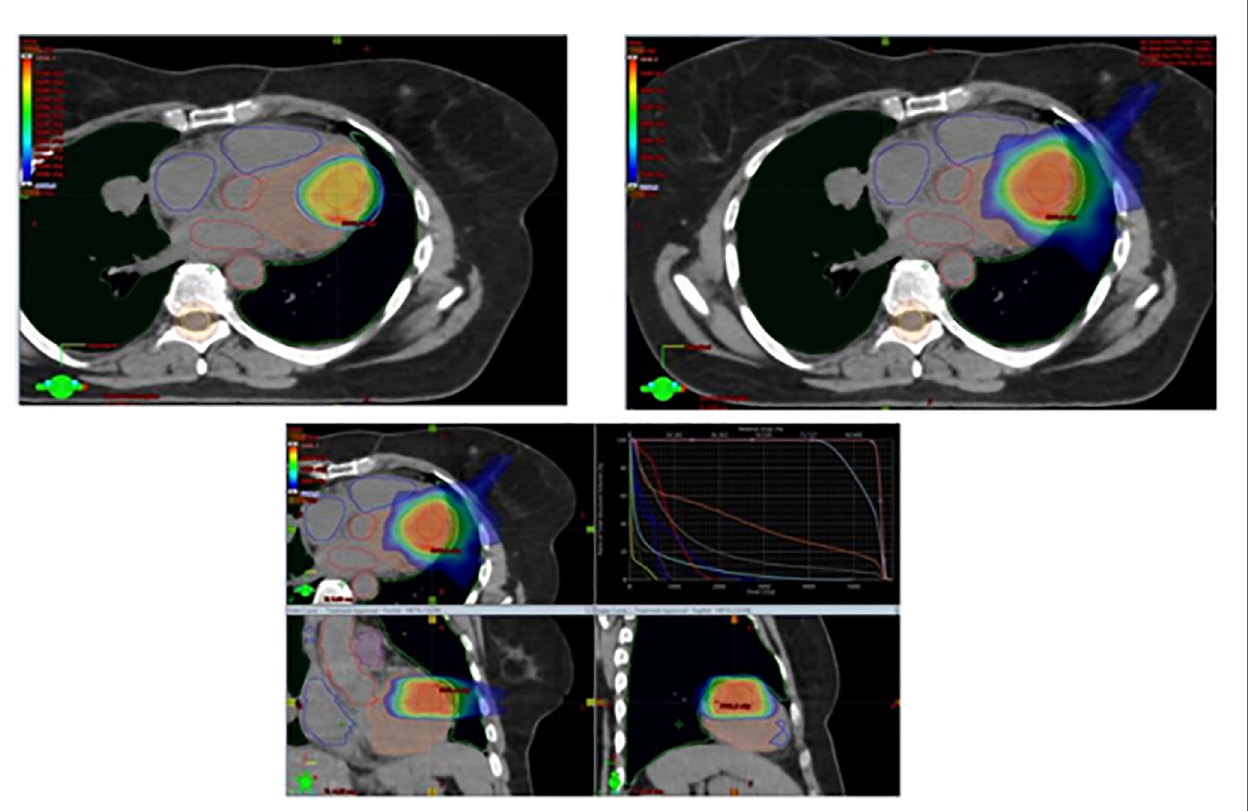
FIGURE 2 | VMAT-IGRT for cardiac progression (CRO Aviano,